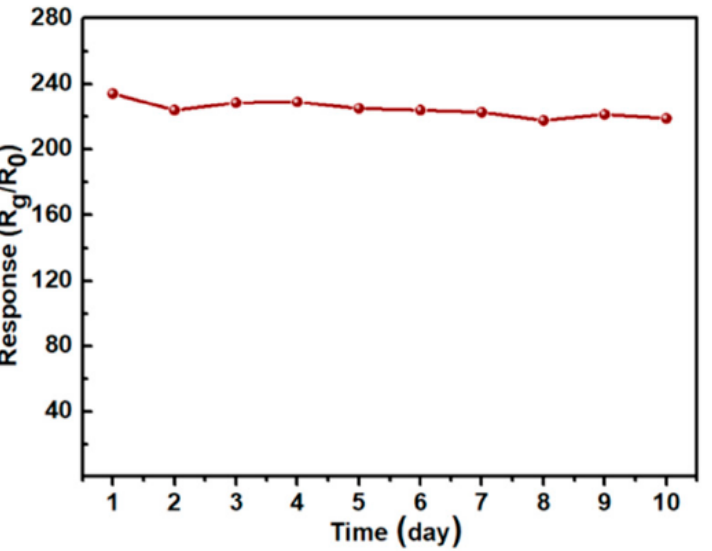
Figure 17. Long-term stability of carbon QD ZnO/gas sensor (100 ppm NO gas/100 °C)